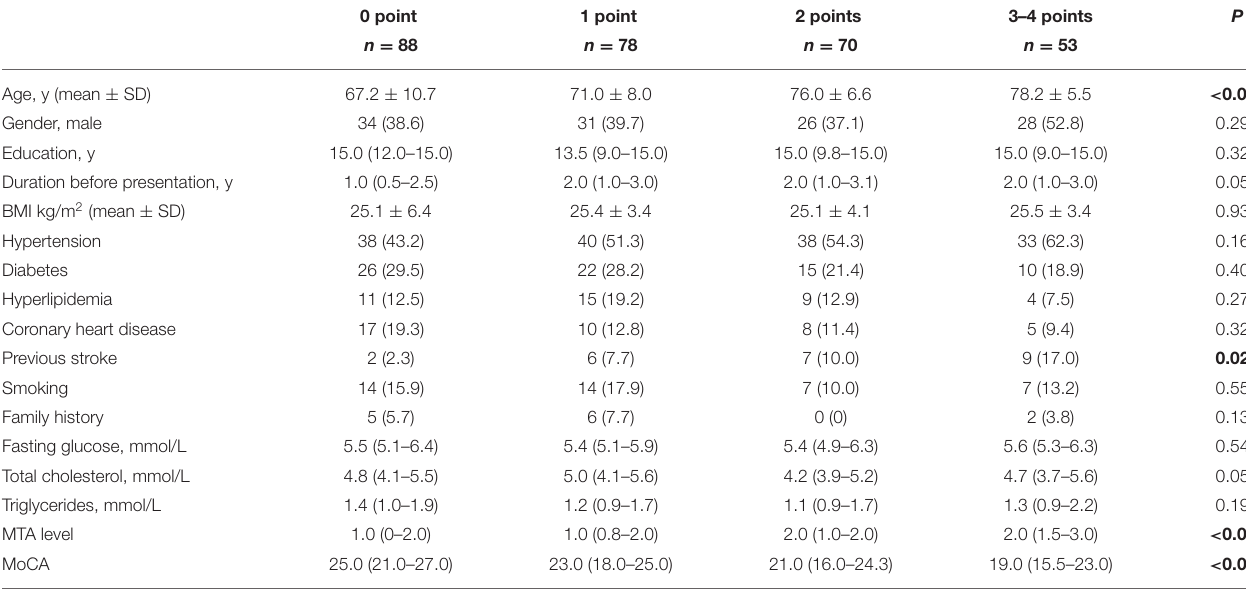
TABLE 3 | The demographic, clinical, and MRI characteristics of patients with amnestic disorders by cSVD score*.